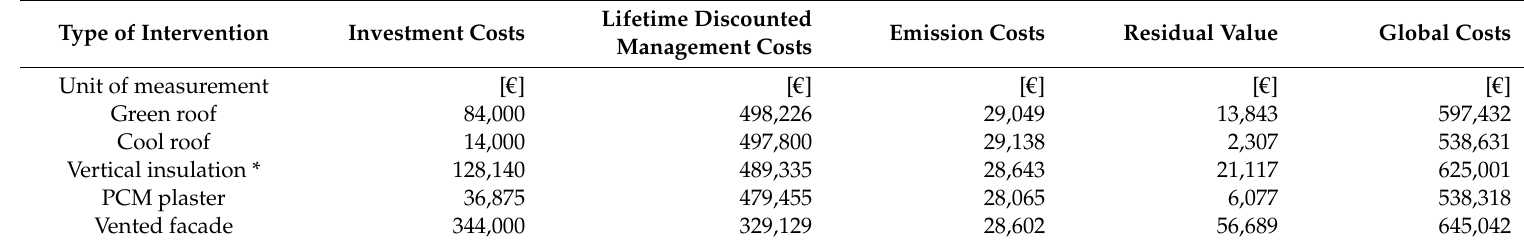
Table 8. Technical and economical analysis according to the indication EU delegated regulation n. 244 / 2012; fuel cost 0.20 € / kWh el , discount rate 3.0%, economic lifecycle = 30